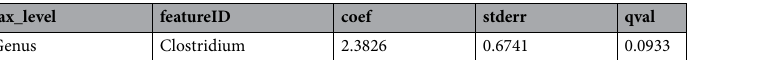
Table 1. Comparison between fecal microbiota in cats with chronic enteropathy and control cats with no gastrointestinal signs. Clostridium was the only genus that was statistically significant after adjusting for multiple